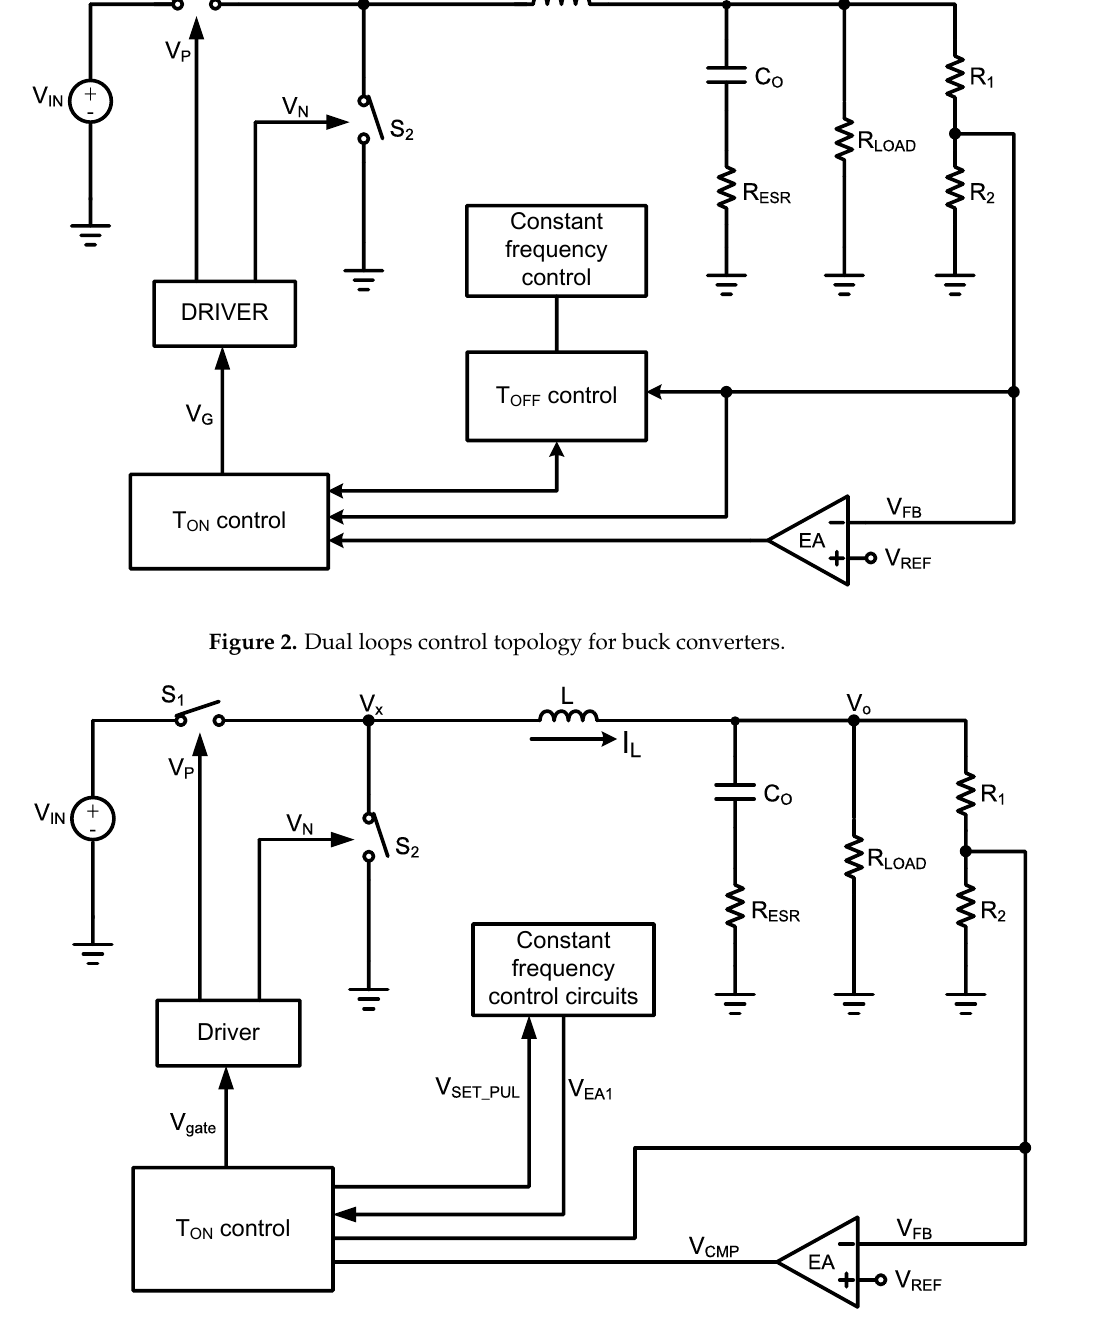
Figure 3. BUCK topology without inductor current sensor.